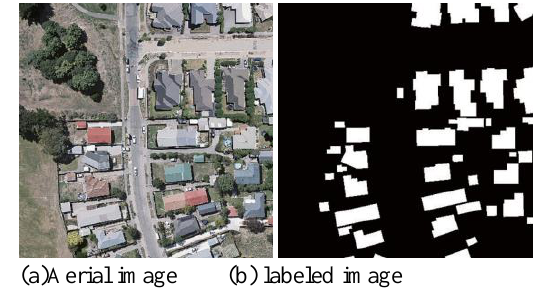
Table 2. Quantitative evaluation of building